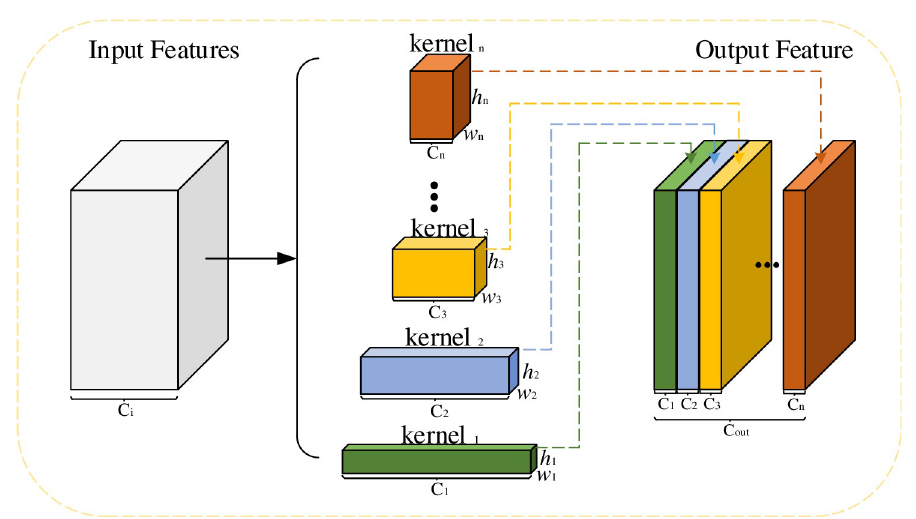
Fig 2. Multi-scale pyramid convolution kernel.